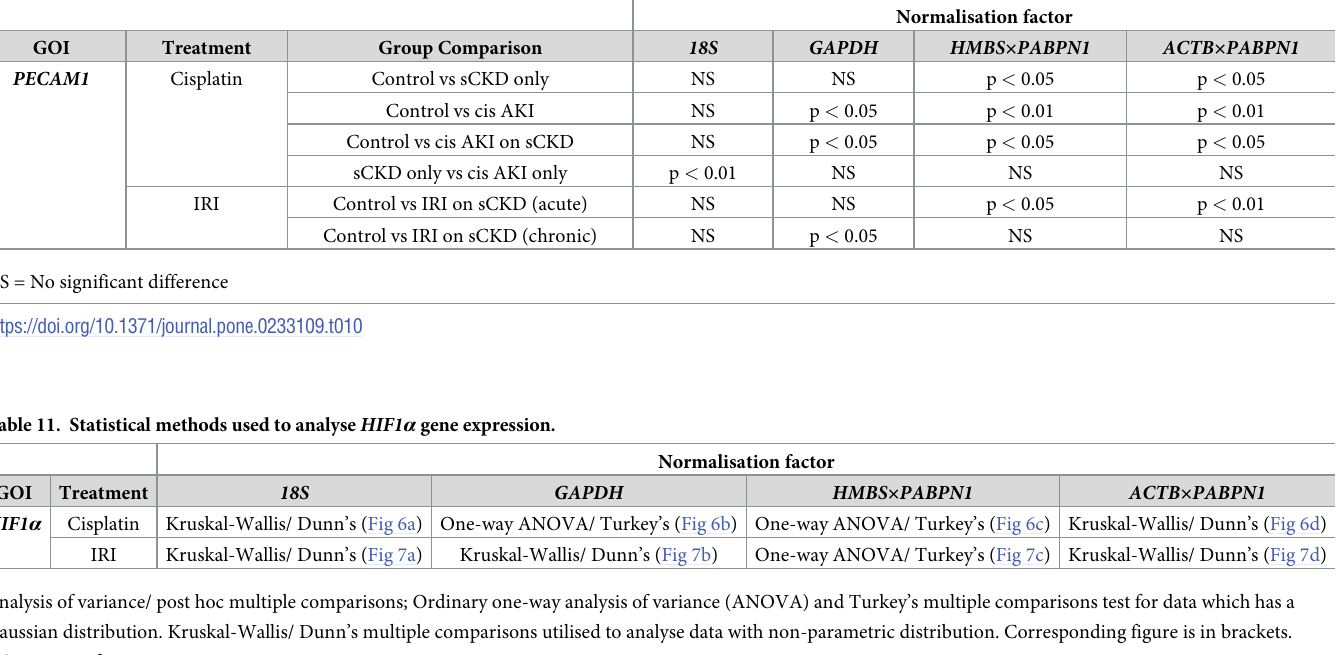
Table 10. Statistical differences of PECAM1 normalised to different reference genes and reference gene combinations.